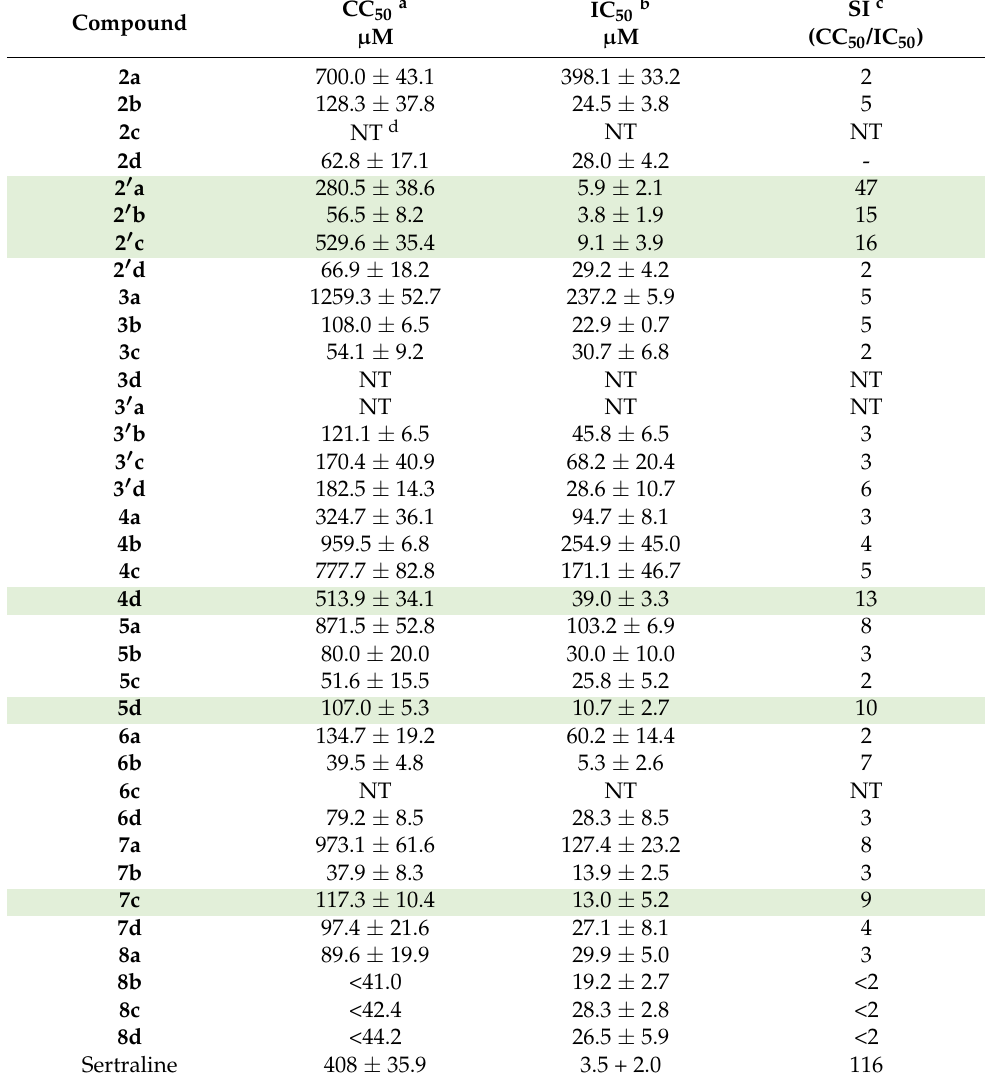
Table 3. Antiviral activity against Marburg pseudovirus (GP MARV).